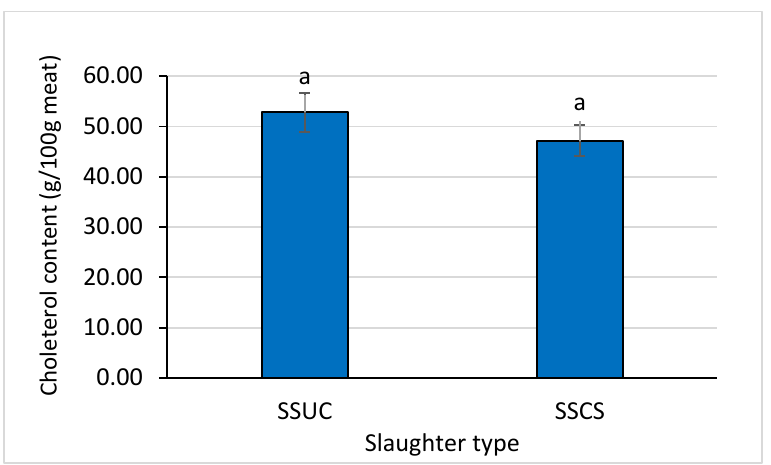
Figure 2. Effect of slaughtering with or without state of consciousness on Longissimus dorsi muscle’s cholesterol content in Korean Hanwoo Finishing Cattle. Bar diagram with similar superscript letters are not significantly different at p < 0.05. Table 2. Effect of slaughtering with or without state of consciousness on Longissimus dorsi muscle’s fatty acid pattern in Korean Hanwoo Finishing Cattle.